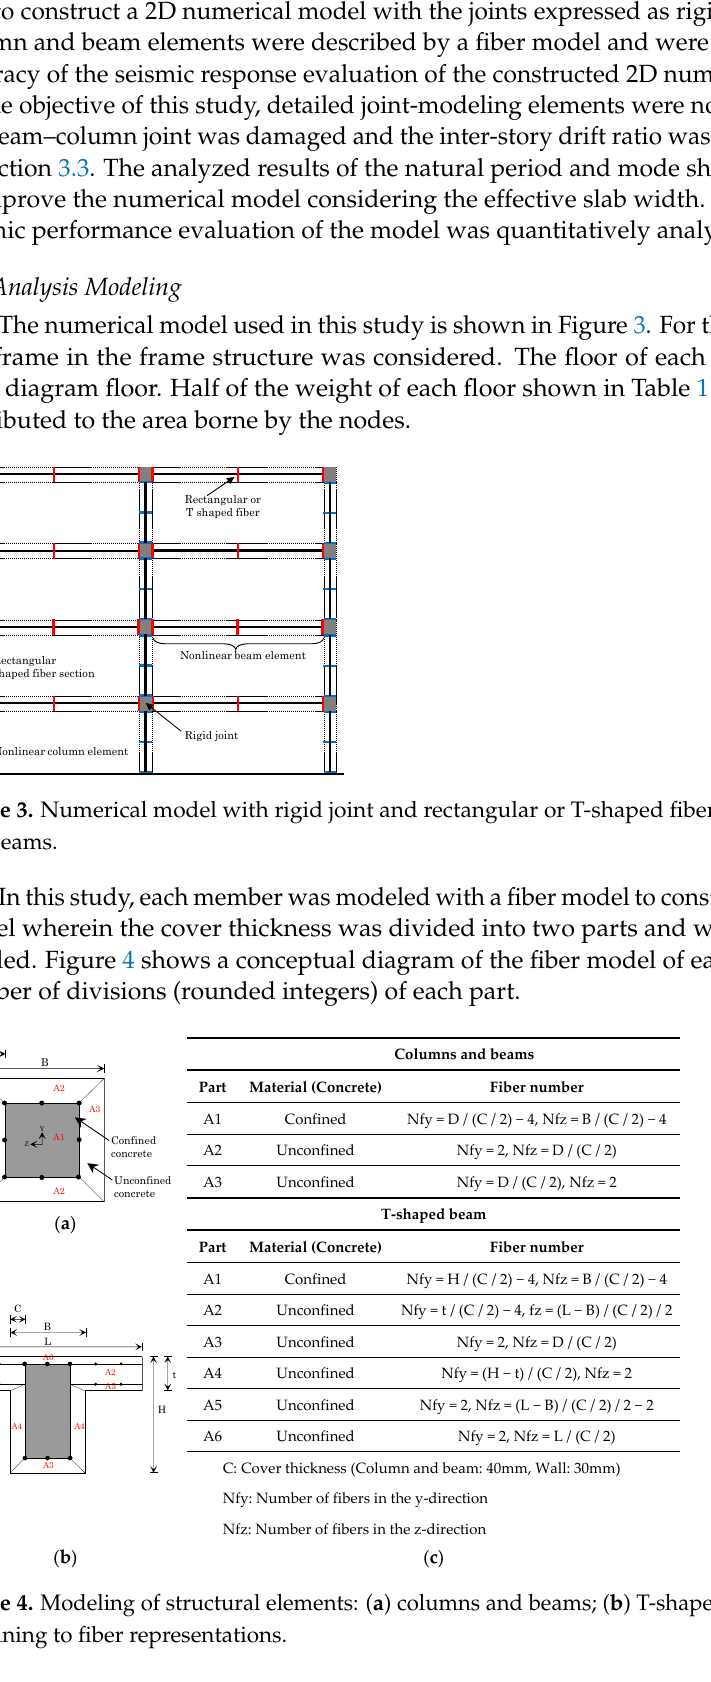
8 of 18 Figure 2. Beam–column damage observations: ( a ) recorded location; ( b ) damage of exterior beam– column joint after the JMA-Kobe tests with amplitudes 50% and 100%; and ( c ) damage of interior beam–column joint after the JMA-Kobe tests with amplitudes 50% and 100 %. 4. Analysis Method The structural analysis program OpenSees [33] was used for analysis. The objective was to construct a 2D numerical model with the joints expressed as rigid regions, while the column and beam elements were described by a fiber model and were used to confirm